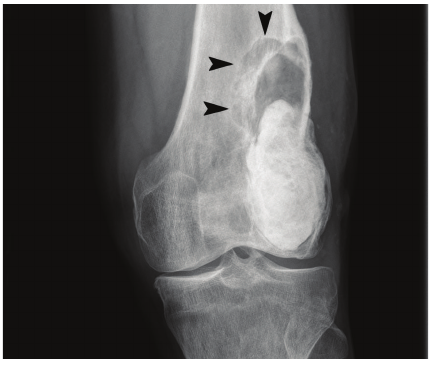
Figure 10: Frontal left knee radiograph (July 2014) demon- strated increased well-defined lytic focus (arrows) surrounding the radiopaque PMMA, suggestive of malignant transformation.